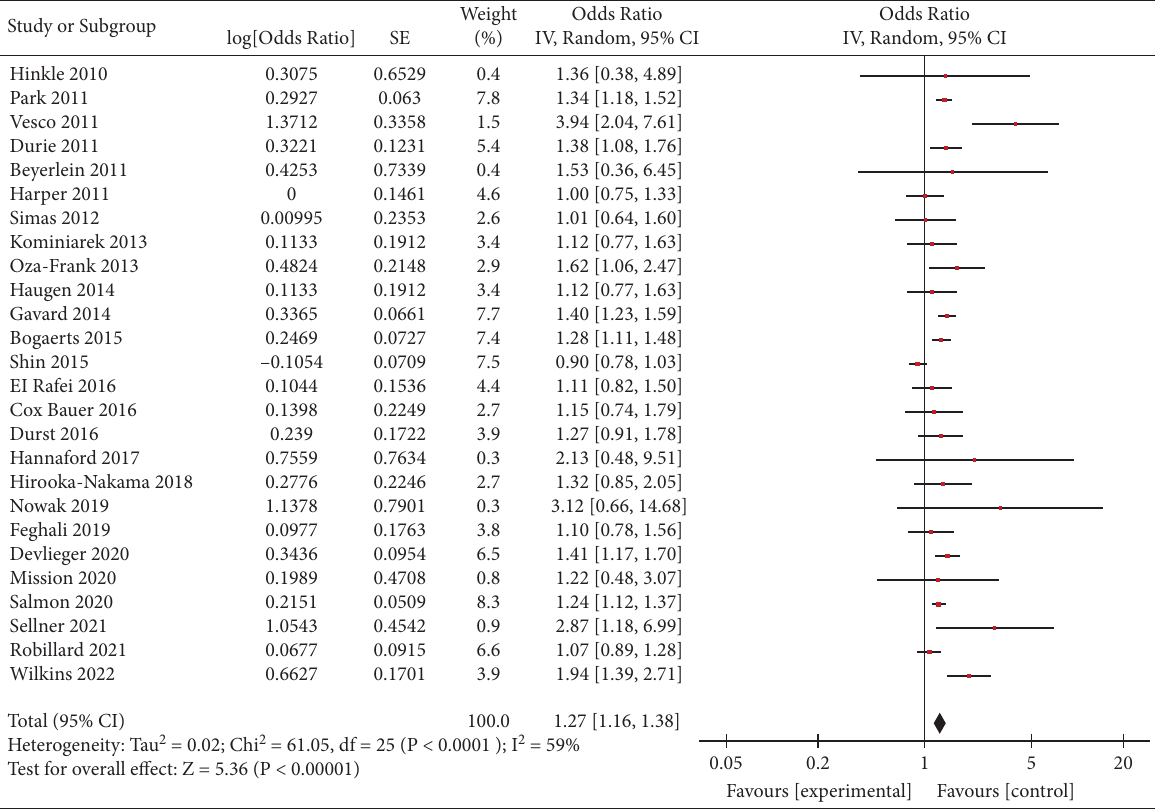
Figure 2: Forest plot of the association between weight gain below the guidelines in obese women and SGA.